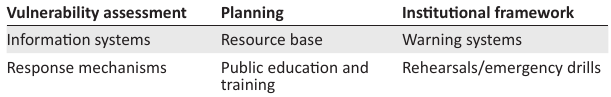
TABLE 1: The disaster preparedness